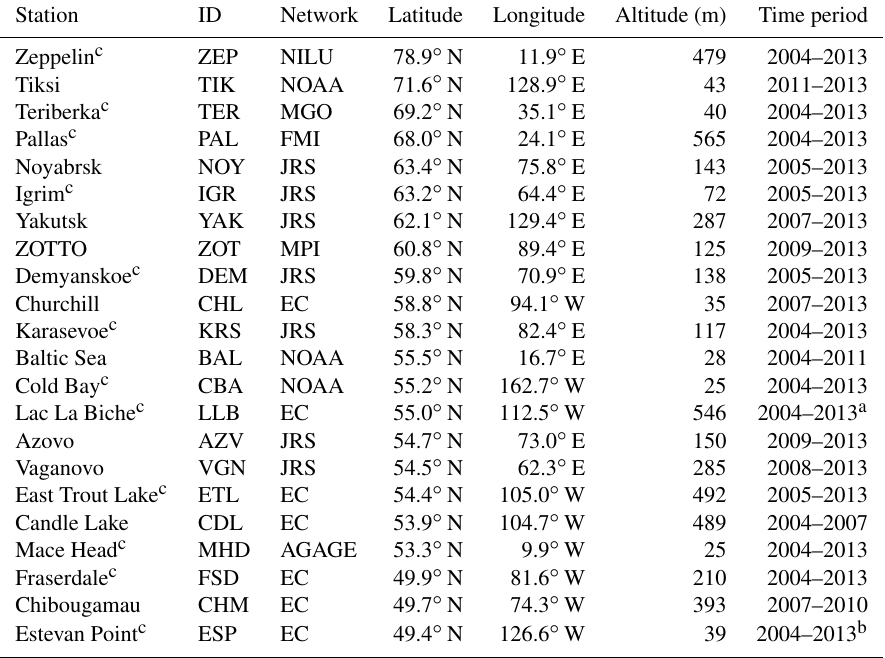
Table 1. Atmospheric measurement sites included in the